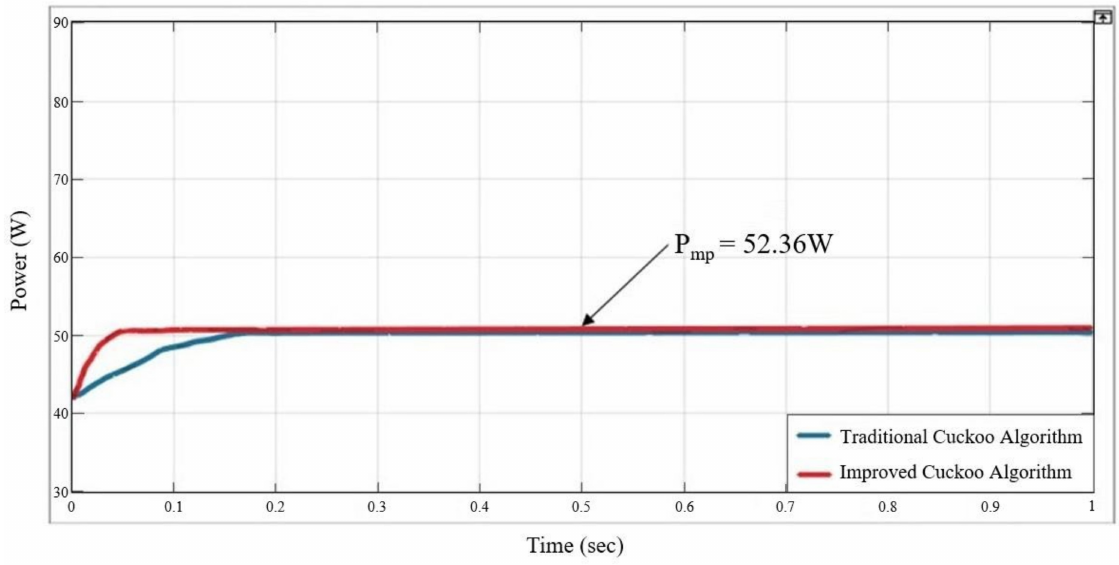
Figure 9. Simulation result of maximum power point tracking of traditional and improved cuckoo algorithm in Case